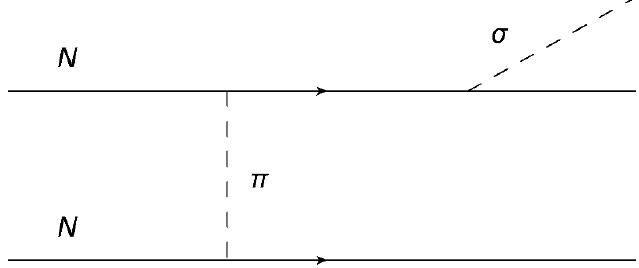
Figure 2. Nucleon-nucleon bremsstrahlung with one pion